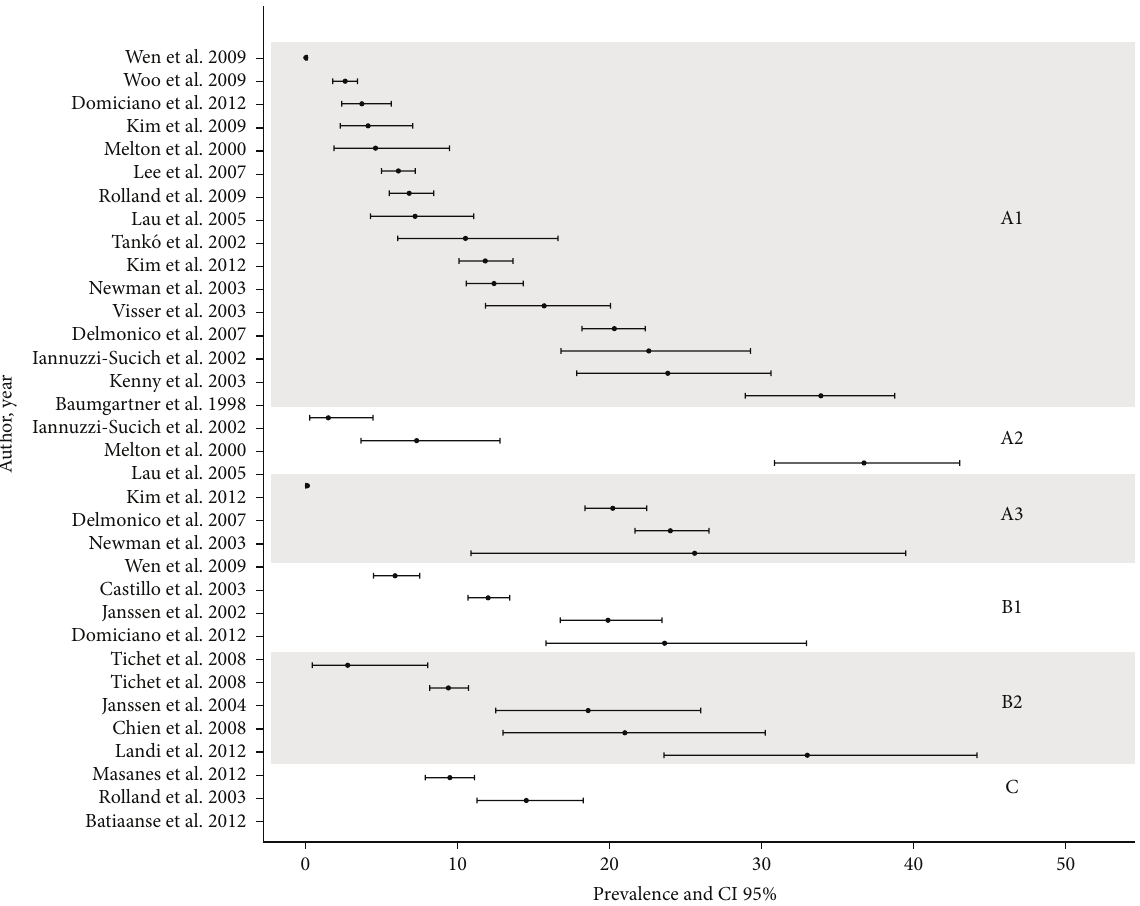
Figure 2: Sarcopenia prevalence and CI 95% in women. (A: DEXA; A1: appendicular skeletal muscle mass index (AMMI); A2: total skeletal muscle mass index (AMMT); and A3: residuals method; B: BIA; B1: skeletal muscle index/height; B2: skeletal muscle index/weight; C: calf